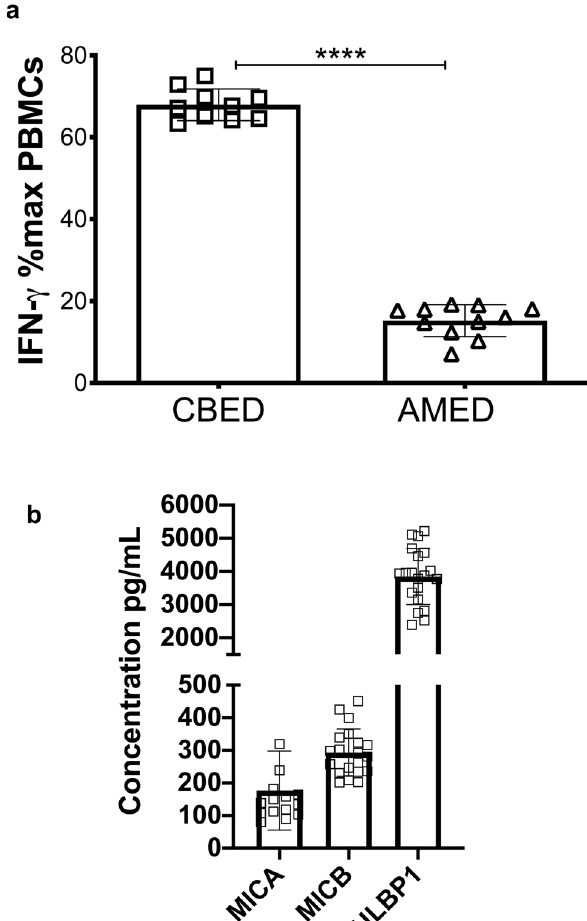
Figure 5. IFN-γ production by PBMCs from healthy donors is reduced by incubation with either CBED or AMED eye drop solutions. ( a ) Results show percentage of maximum IFN-γ expression in culture supernatants relative to complete media following 2-h stimulation with PMA and ionomycin. Eye drop preparations investigated were CBED (n = 10) and AMED (n = 10). PBMCs were cultured with 50% eye drop solution (diluted with complete media and IL-2) or complete media and IL-2 only, for 48 h prior to PMA and ionomycin stimulation. Each experiment was repeated with four different PBMC donors and data points represent donor means. ( b ) ELISA quantification of soluble NKG2D ligands (sMICA, sMICB and sULBP1) in CBED in pg/mL. Statistical analysis was performed using nonparametric Mann–Whitney test. p < 0.0001 ( ****